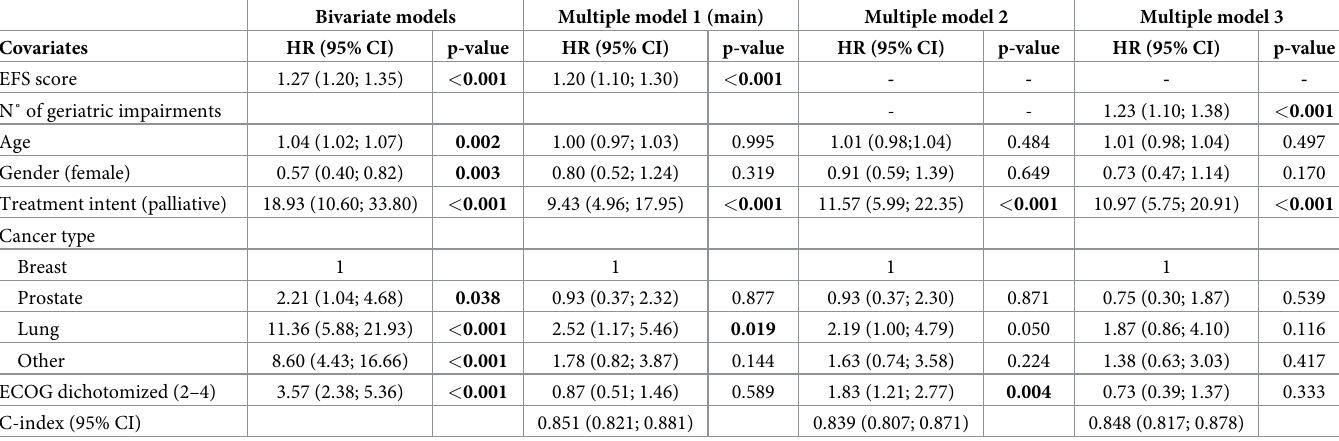
Table 4. Cox proportional hazard models estimating the relationship between covariates and overall survival.